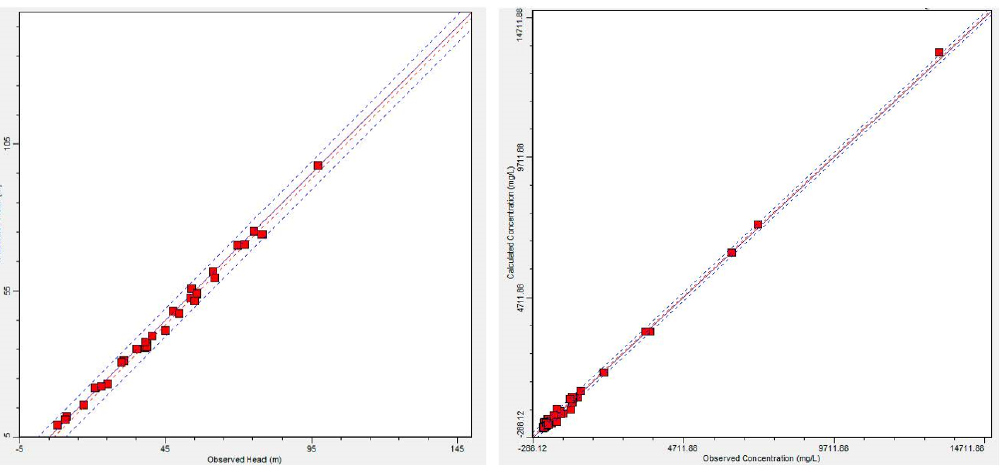
Figure 4. Scatter diagram of groundwater head and salt concentration at the end of calibration showing the match between observed and model-computed